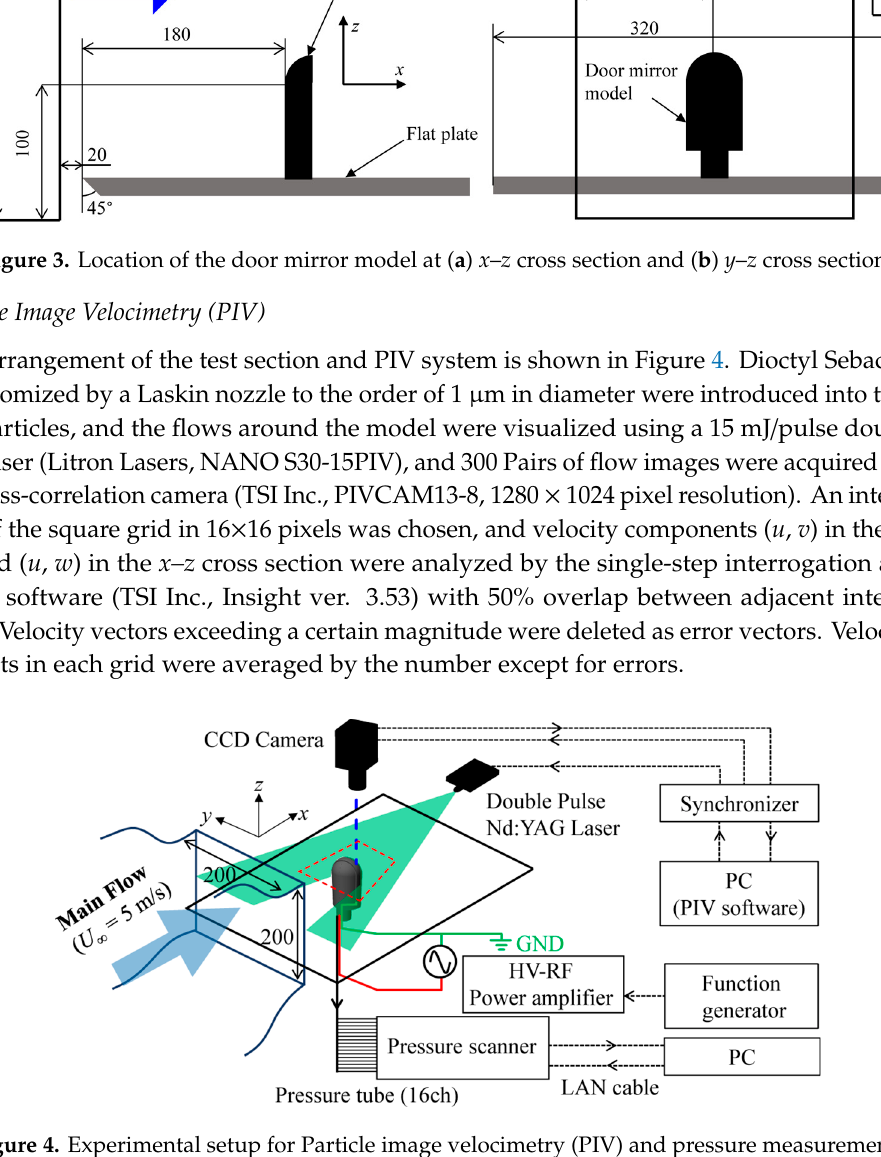
Figure 2. ( a ) External view of car door mirror model, and ( b ) internal structures in the x – z cross section.